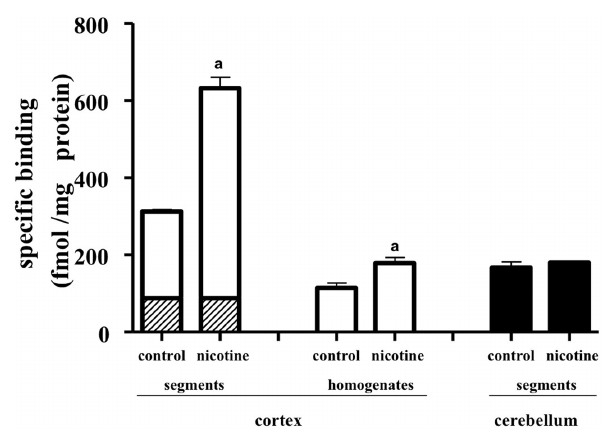
FIGURE 4 | Effects of chronic administration of nicotine for 3weeks. The tissue segments or homogenates of the cerebral cortex and cerebellum in nicotine-treated and untreated rats were incubated with [ 3 H]-epibatidine for 28h (segments) or 5h (homogenates) at 4˚C.The total density of [ 3 H]-epibatidine binding sites was estimated from saturation experiments in the cortex and from 2nM [ 3 H]-epibatidine binding in the cerebellum. From the competition curves for nicotine, high-affinity (open column), and low-affinity sites (hatched column) for nicotine were calculated in the cerebral cortex.The binding sites in the cerebellum were not characterized by nicotine and were represented as black columns. Control, rats not treated with nicotine; nicotine, nicotine-treated rats. Mean ± SEM of four experiments. a: Significantly different from those of the control